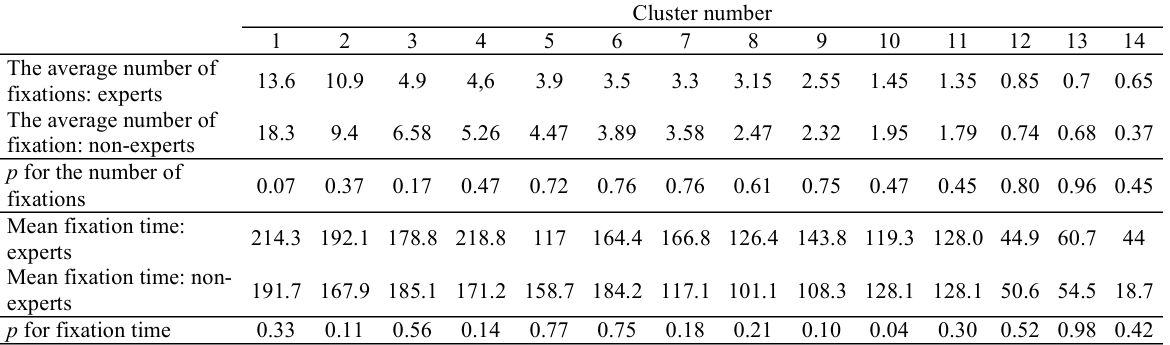
Table 10. Average feature values (number of fixations) for experts and not of experts and t-value calculated for individual clusters designated for image